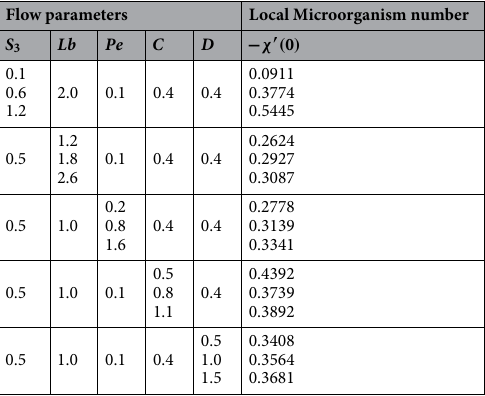
χ ′ ( 0 ) versus flow parameters. −